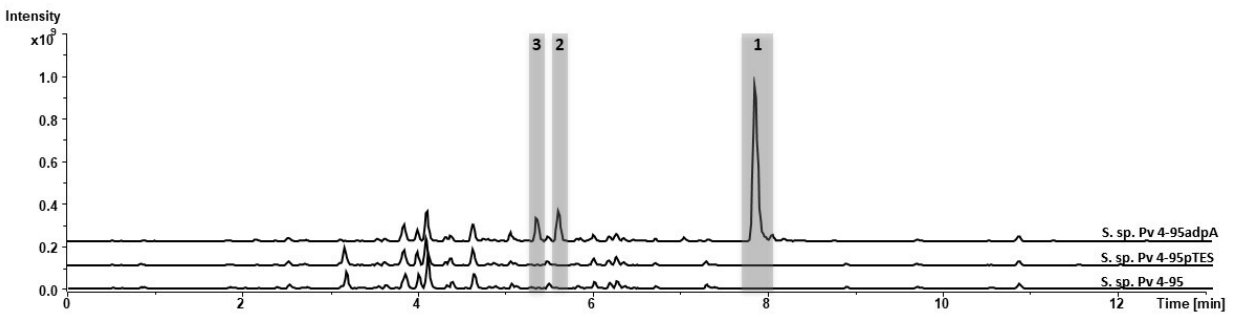
Figure 2. Chromatograms of the crude extracts from the Streptomyces sp. Pv 4-95adpA, which contains